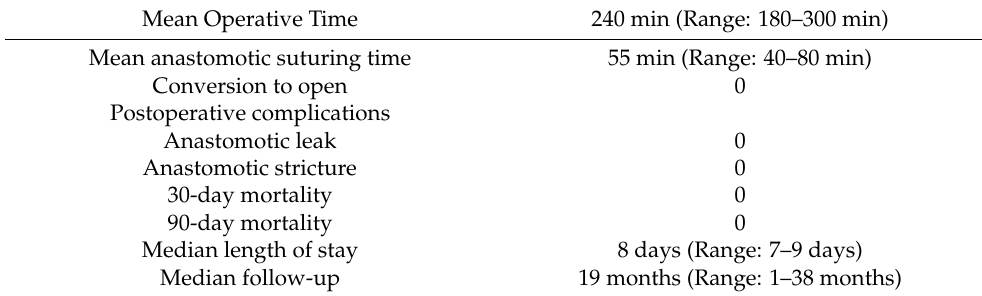
Table 2. Operative and clinical